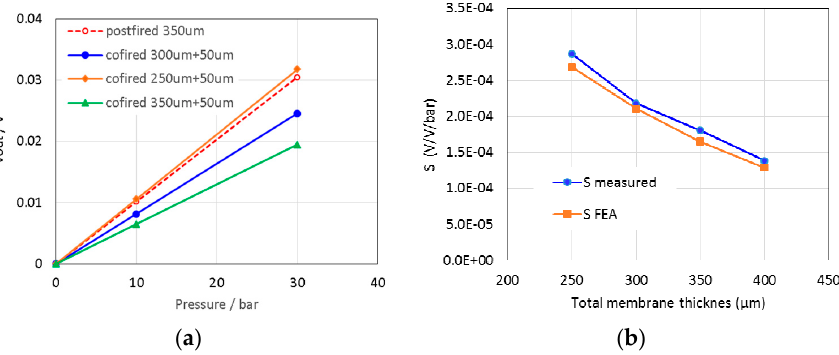
Figure 9. ( a ) Simulated characteristics of 10-bar sensor (at 25 °C) in dependence of the total thickness of the diaphragm. ( b ) Numerically obtained and the measured sensitivity.